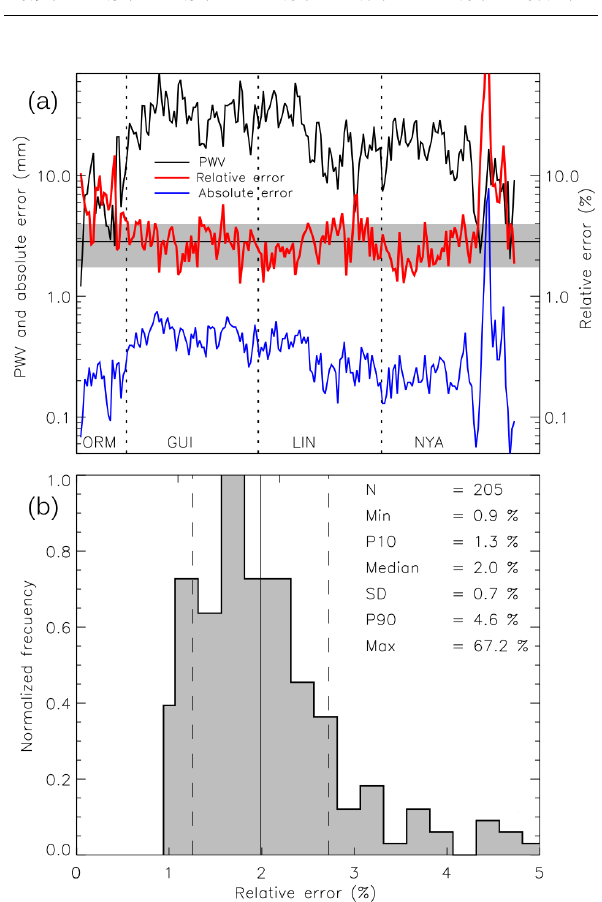
Figure 7. Relative error ( (cid:15) rel ) statistics. Panel (a) shows all the PWV values (black), plotted together with their absolute (blue) and relative errors (red) in a logarithm scale. The thin horizontal line and shadow show the median relative error and dispersion. The disper- sion has been estimated robustly by means of 1 . 4826 × MAD, where MAD is the median absolute deviation and 1 . 4826 is the scale fac- tor between MAD and the standard deviation for perfect Gaussian distributions. Panel (b) shows the histogram of the distribution of relative errors. The vertical lines show the median value and disper- sion range (dashed). The main statistics is in the